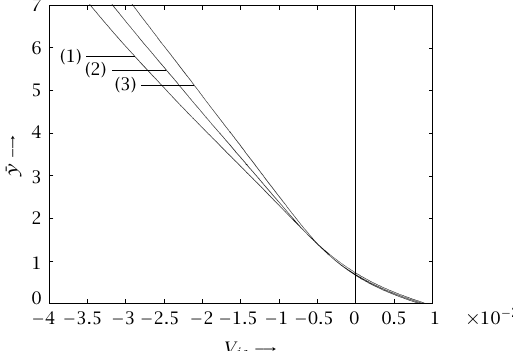
Figure 4.12 . Induced steady transverse velocity component of the fluid V is in the boundary layer for R = 500, 4 = 0 . 05. (1) X = 1, λ = 0 . 01, (2) X = 1, λ = 0 . 36, (3) X = 1, λ = 0 . 71.